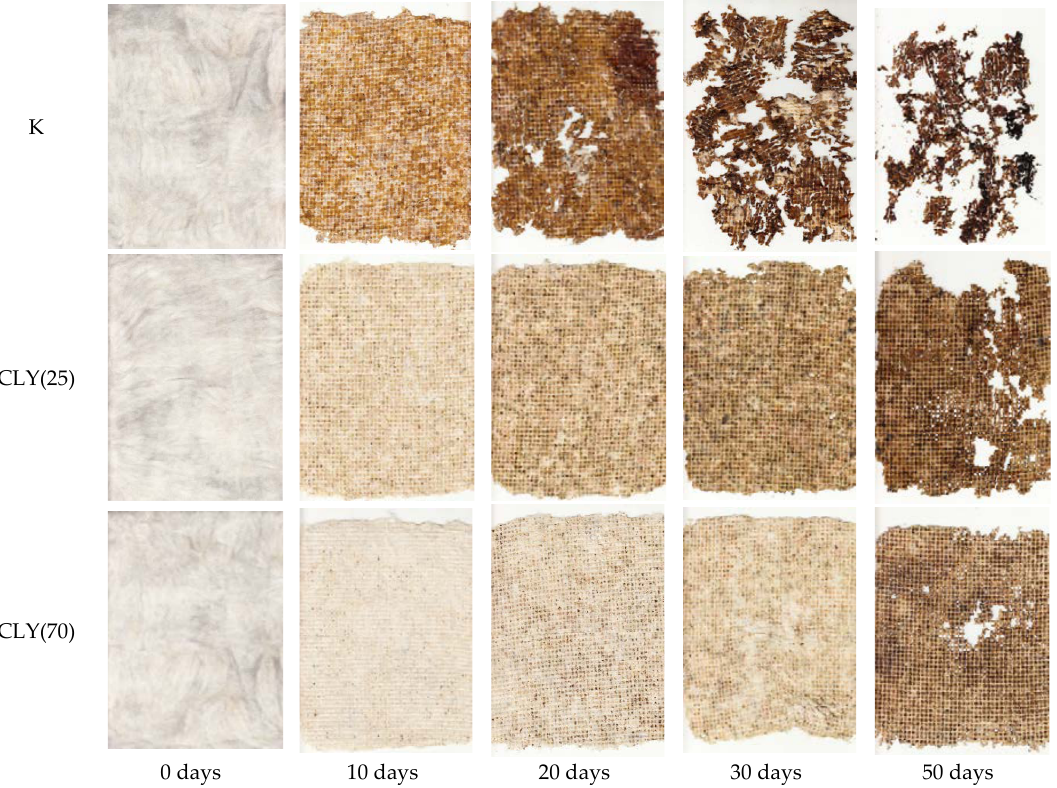
Figure 6. Photos of the K, CLY(25), and CLY(70) samples before (0 days) and after 10, 20, 30, and 50 days of soil burial.